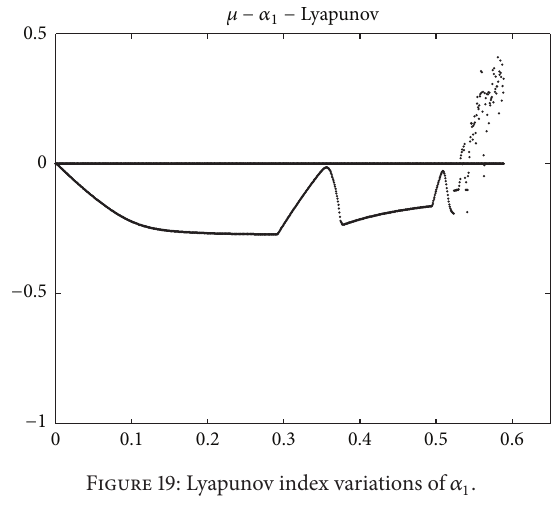
Figure 19: Lyapunov index variations of 𝛼 1 .